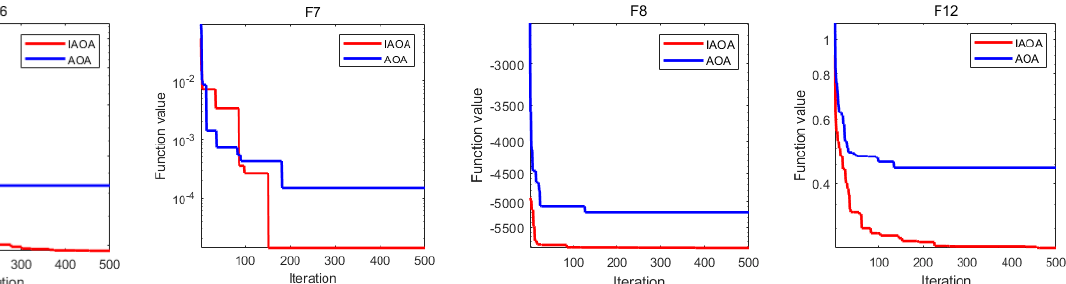
Figure 1. Convergence curves of functions F6, F7, F8, and F12. The blue and red curves represent